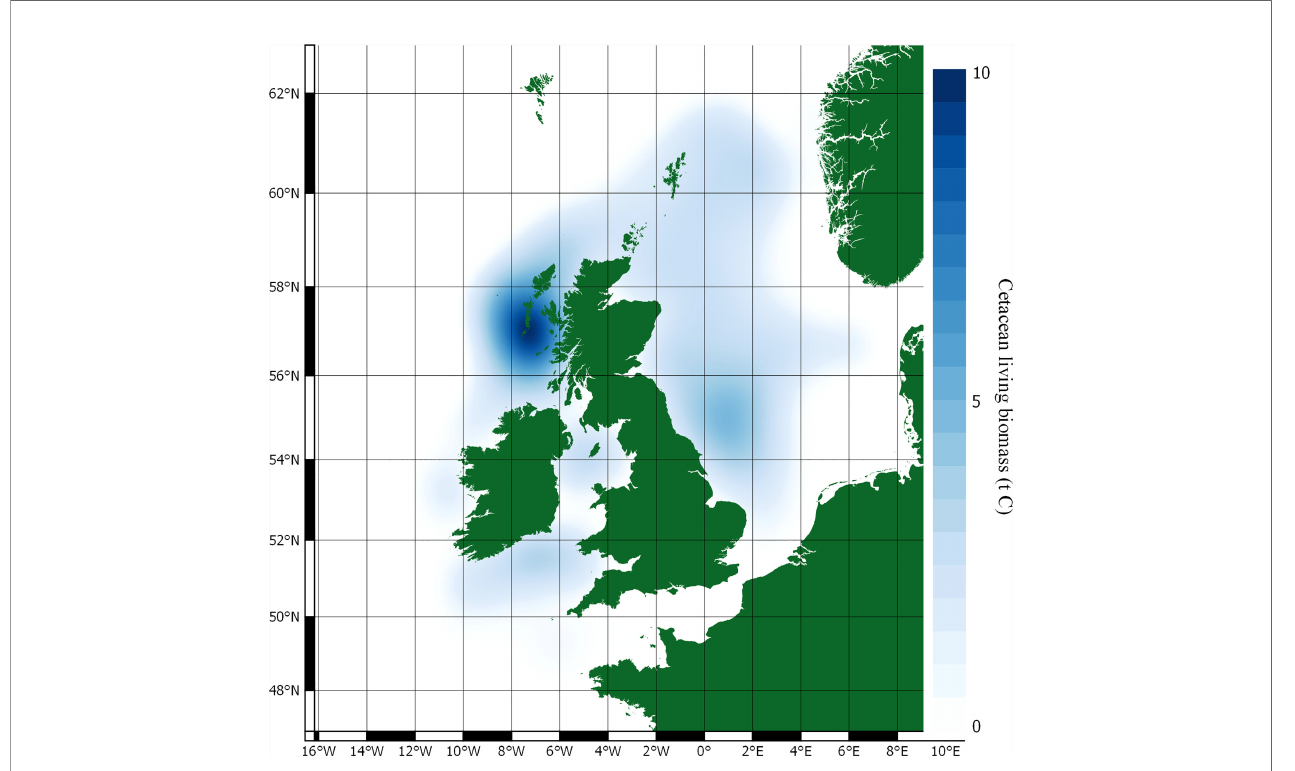
FIGURE 3 | Carbon stocks in cetacean living biomass.